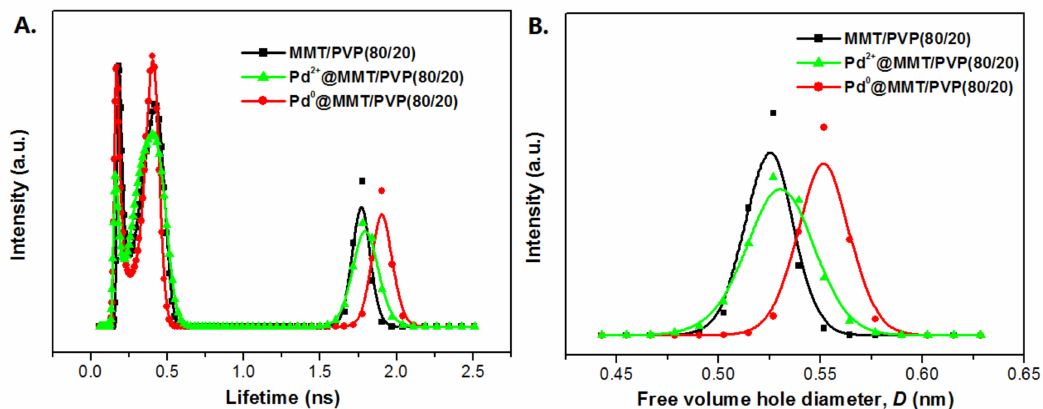
Figure 4. The distribution of positron annihilation lifetime ( A ) and calculated micro defects size ( B ) of MMT/PVP support, Pd 2+ @MMT/PVP and Pd 0 @MMT/PVP catalytic composite.